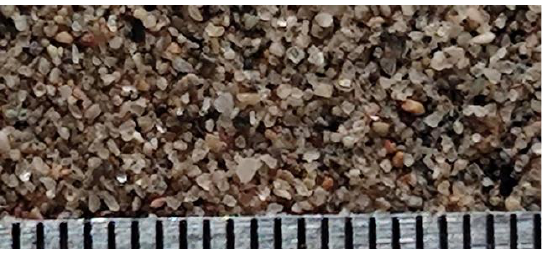
Figure 2. Microscopic image of test material (0.5 mm/grid).